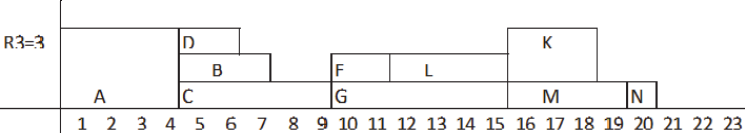
Fig. 16. Improvement in resource utilization for